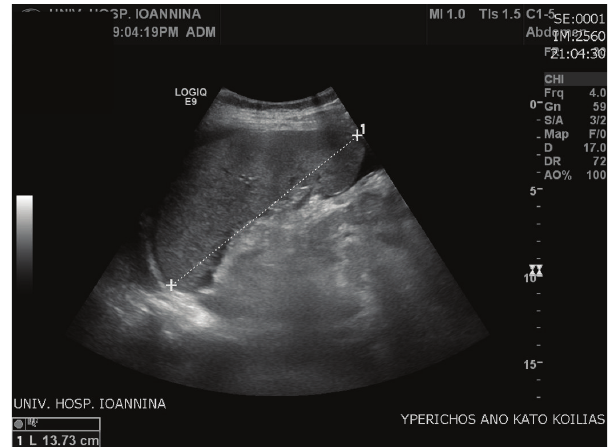
Figure 1: Ascites (fluid accumulation in the peritoneal cavity).